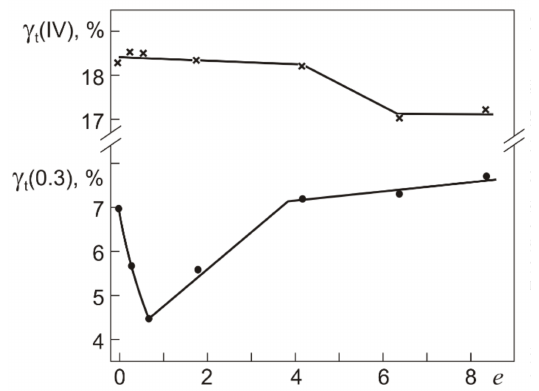
Figure 7. Total strains γ t (0.3) and γ t (IV) at which τ 0.3 and τ 0.3 (IV) are reached in Ti 49.8 Ni 50.2 after warm abc pressing with di ff erent true strains e